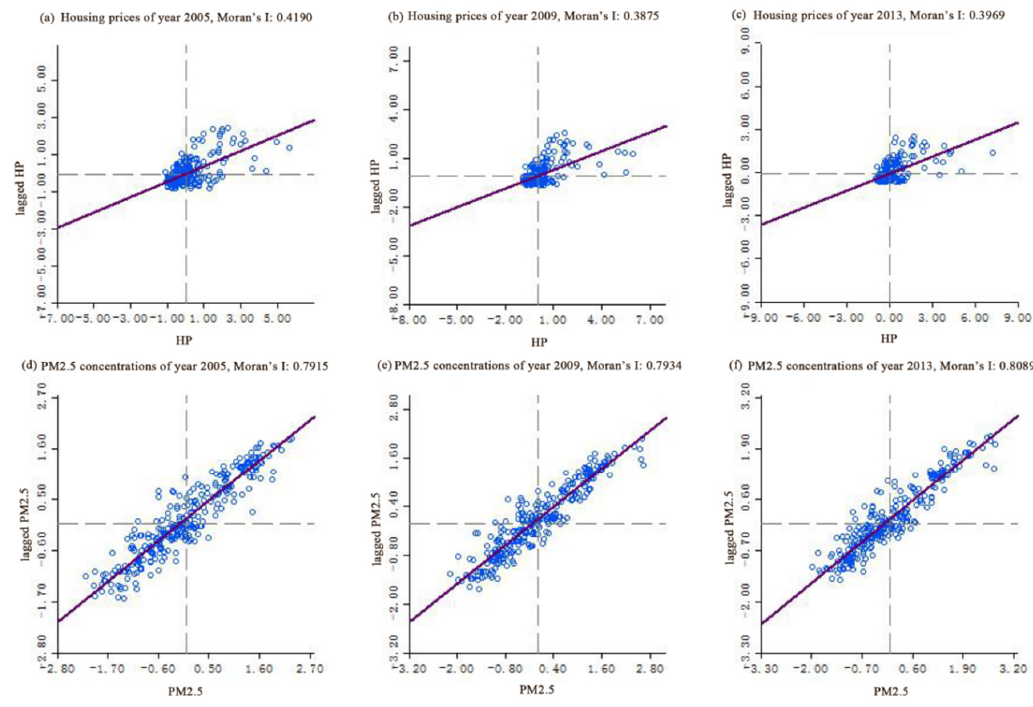
Figure 4. Moran’s I scatter of housing prices and PM2.5 concentrations from 2005 to 2013. ( a )–( c ) represent the Moran scatter of housing prices in 2005, 2009 and 2013 respectively; ( d )–( f ) represent the Moran scatter of PM2.5 concentrations in 2005, 2009 and 2013 respectively.